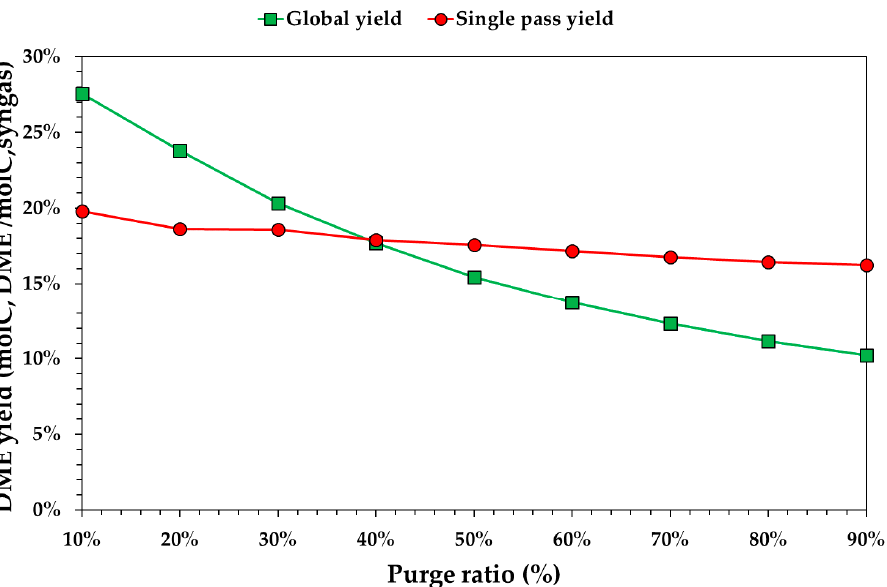
Figure 11. Theoretical equilibrium DME yield (global or single pass) with respect to the purge ratio, fixing WGS conversion and the CO 2 capture to 0% and to 85%, respectively.